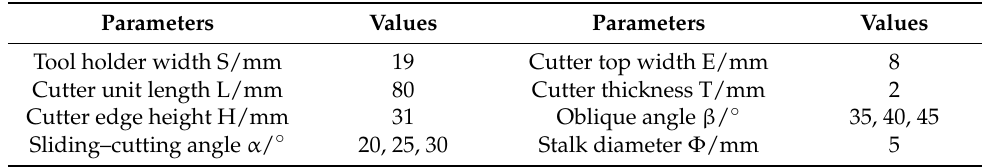
Table 1. Primary parameters of the geometric model.